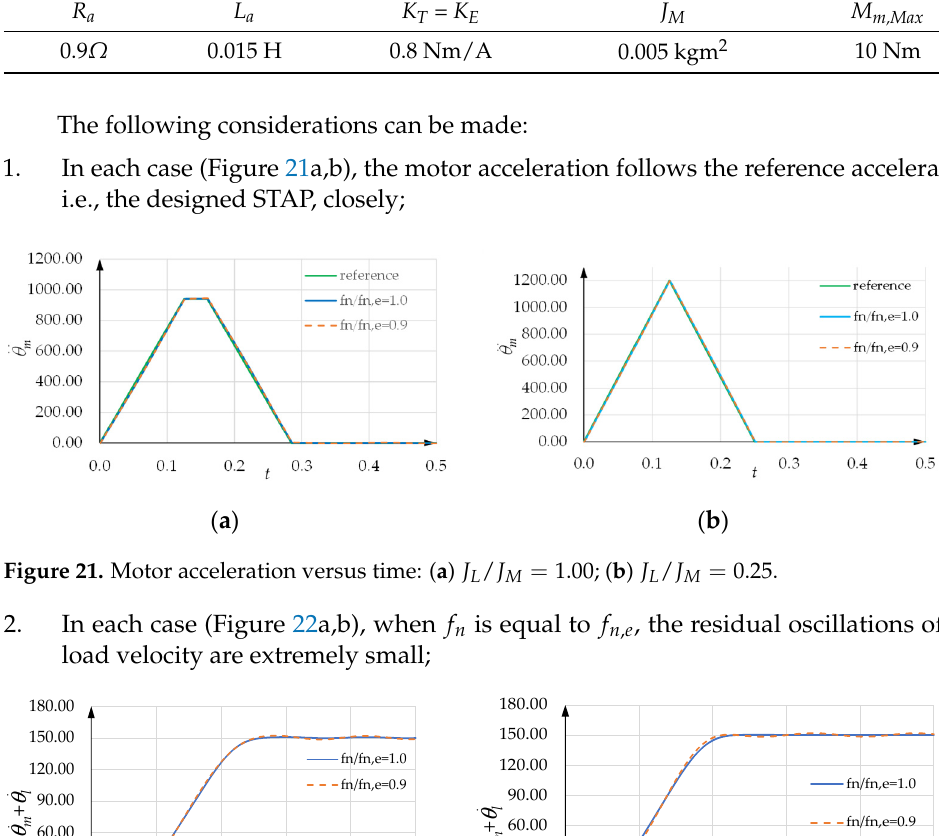
Figure 22. Load velocity versus time: ( a )